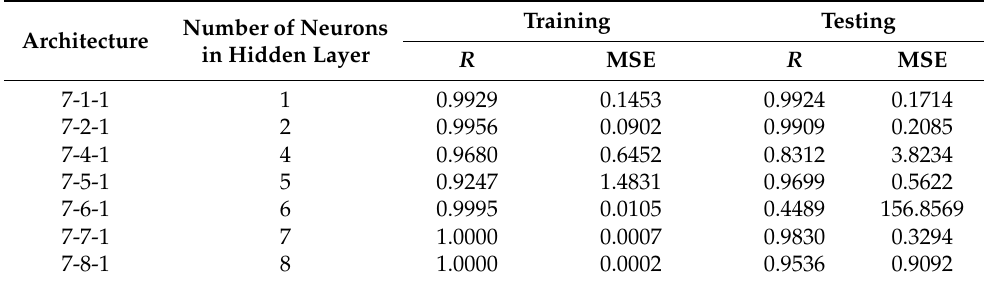
Table 7. Results of BPNN for Different